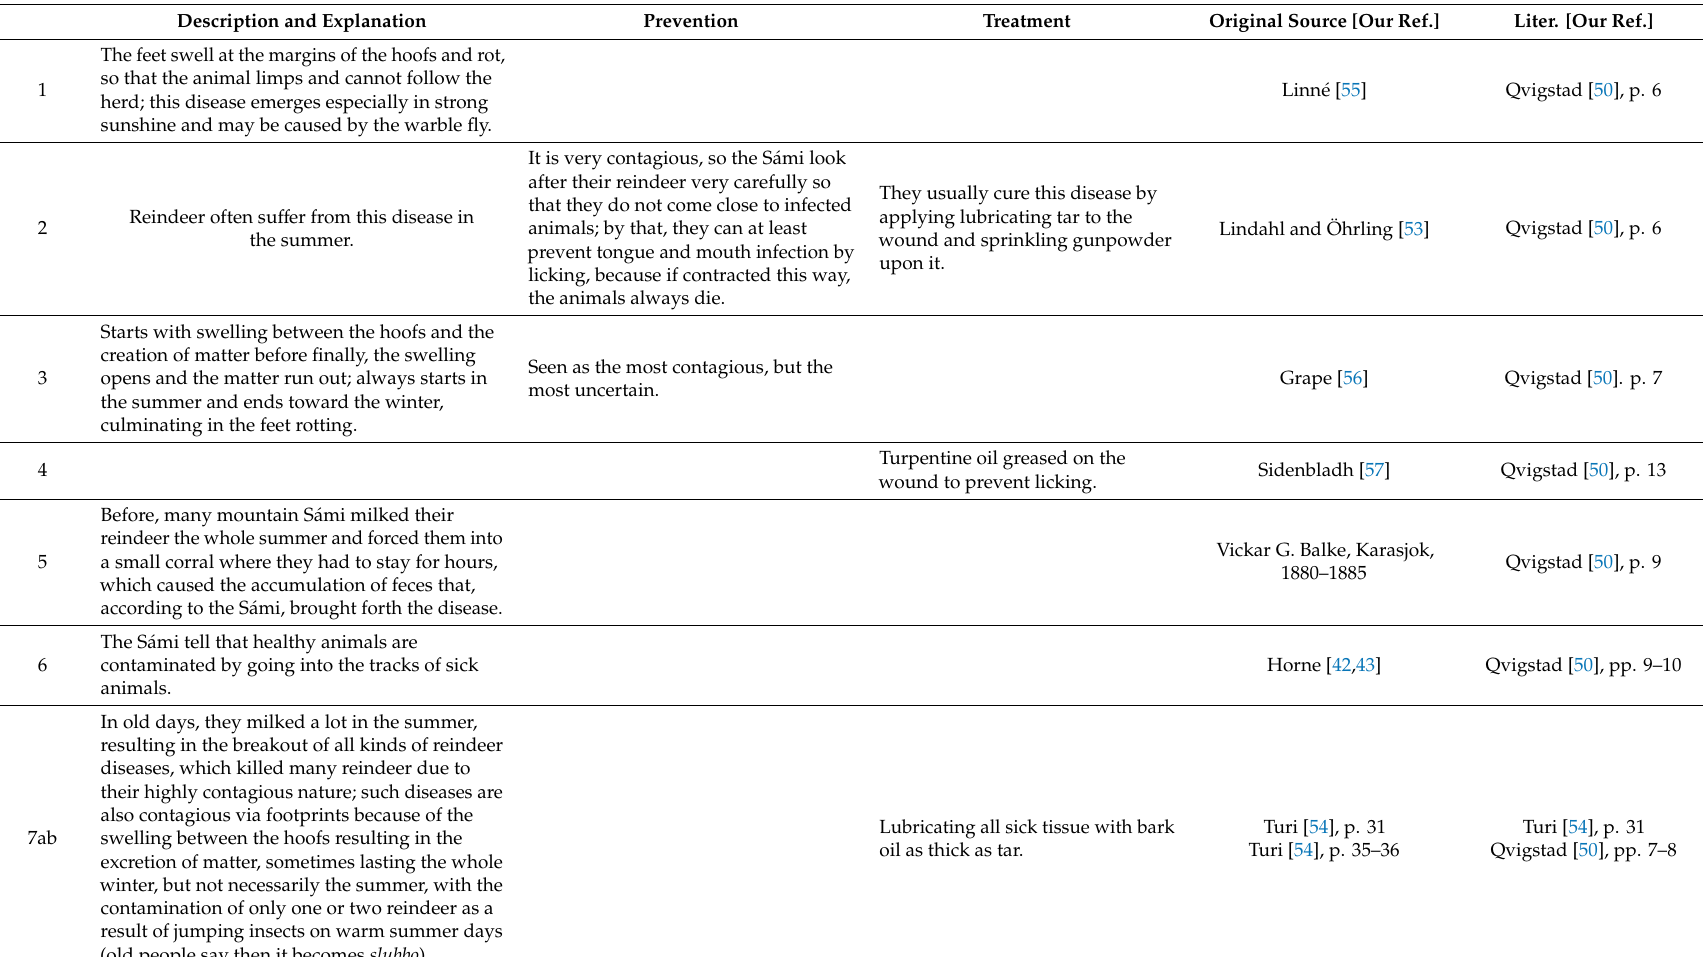
Table 1. Traditional knowledge on foot rot (digital necrobacillosis) in the